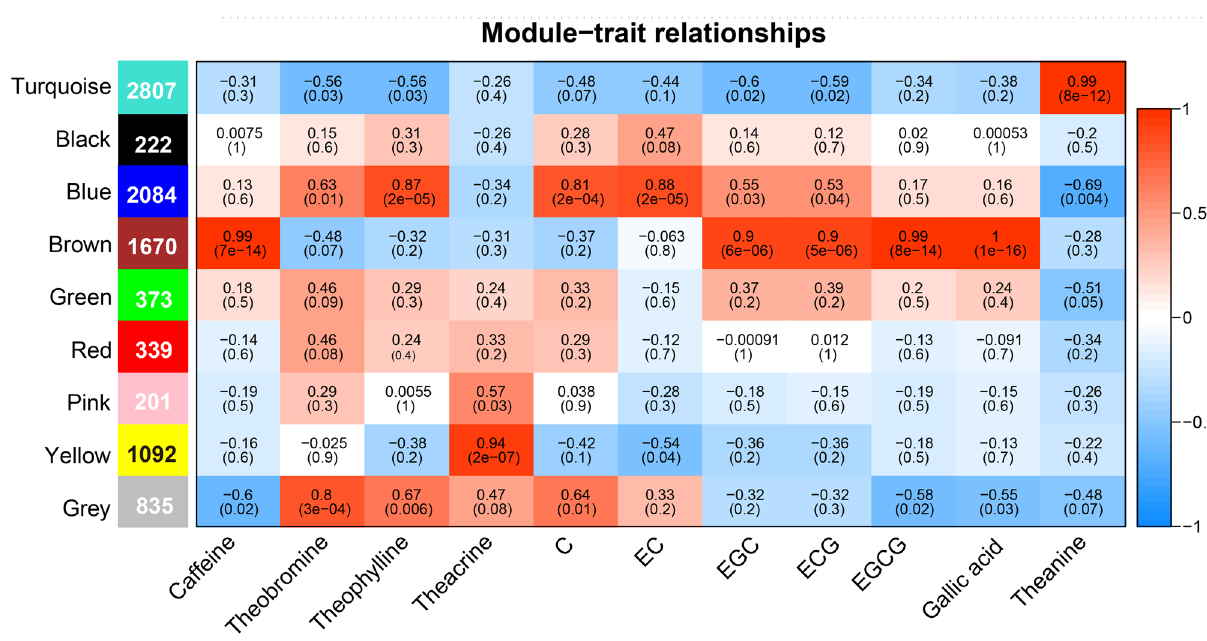
Figure 5. Biosynthetic pathway and gene expression analysis of caffeine metabolism. The orange letters indicate enzymes associated with the metabolites. Heat map showing the relative expression level of genes in QC1-TL and SDT-TL. Data represent the mean values of three biological replicates.